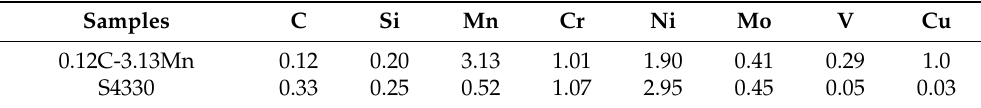
Table 1. Nominal composition of 0.12C-3.13Mn steel and S4330 steel (wt.%).